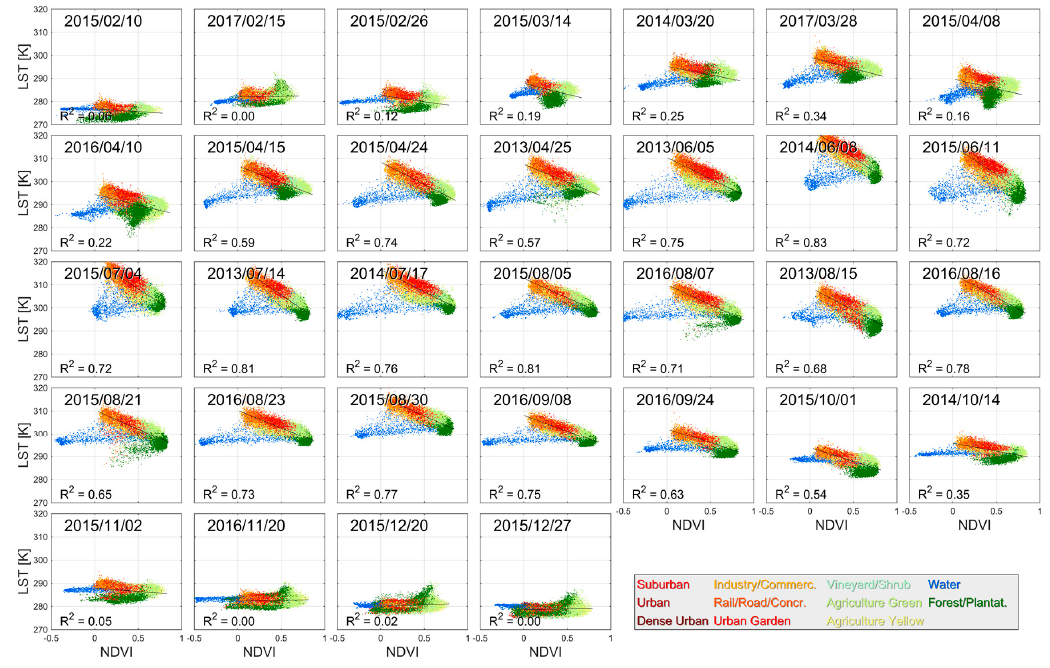
Figure 9. Scatterplot showing the dependence of LST on the NDVI. The markers are colored after the most frequent class in the specific cell. The plots are ordered after the DOY from the upper left to the lower right corner. R 2 and the regression line are calculated without water-contaminated pixels.